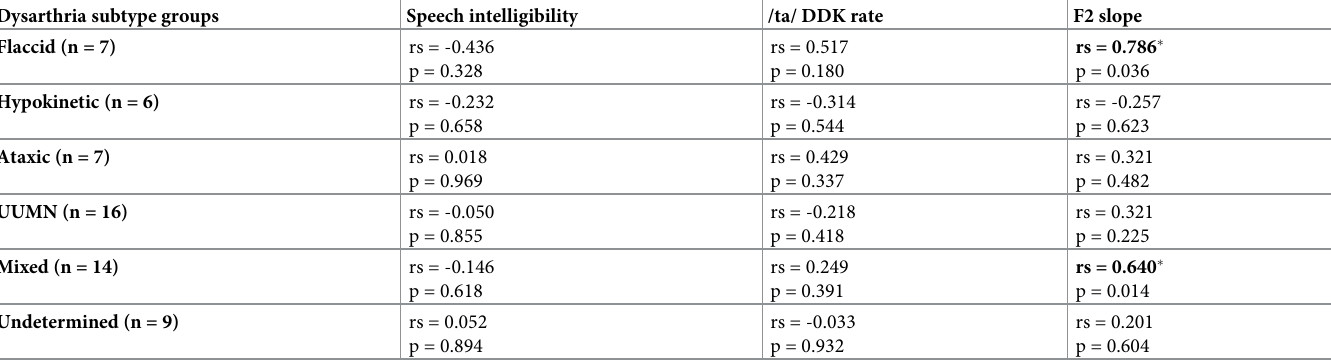
Table 4. Spearman’s rank correlation coefficients (two sided) between the maximum tongue pressure and speech measures for each subtype of speakers with dysar- thria (Total n = 59). Dysarthria subtype